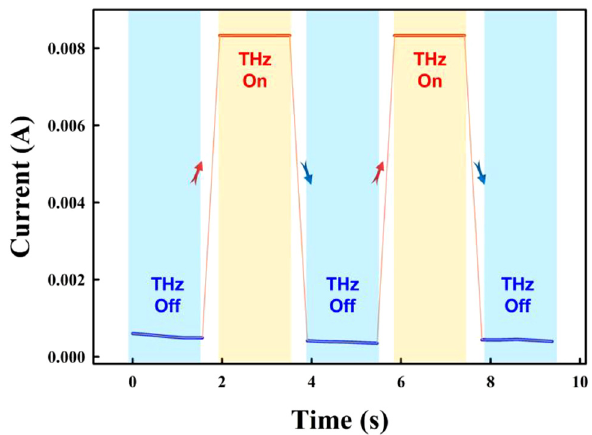
Figure 7: The response time of the device.